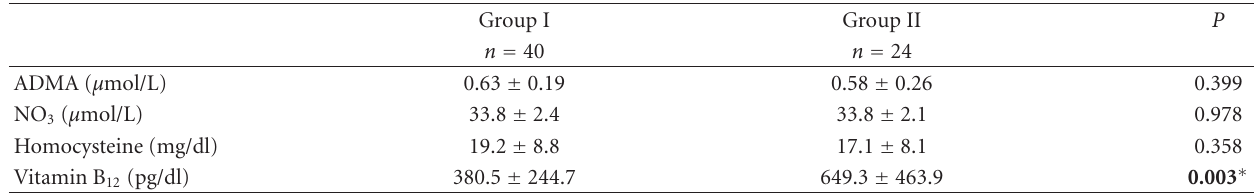
Table 2: Pretreatment ADMA, NO 3 , homocysteine, and vitamin B 12 levels in patients with normal pulmonary pressure (Group I) and patients with high pulmonary pressure or who died (Group